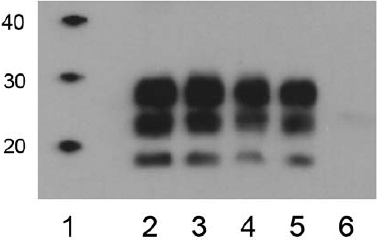
Figure 2. Western immunoblot of PrP res in the brainstem of reindeer compared to elk and white-tailed deer CWD inocula. Reindeer 12 (lane 4) and reindeer 47 (lane 5) developed terminal CWD at 18.5 and 20 mpi. Lane 1– molecular weight marker (kDa), lane 2– CWD in elk, lane 3– CWD in white-tailed deer, lane 4– CWD in reindeer 12, lane 5– CWD in reindeer 47, lane 6– negative control elk.